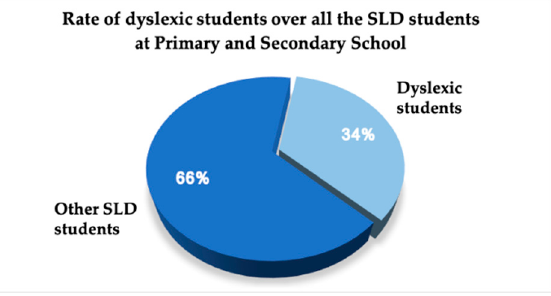
Figure 1. Rate of dyslexic students over all the SLD students attending Italian primary and secondary school, according to the 2019 report of Ministry of Education and Ministry of University and Research [75].